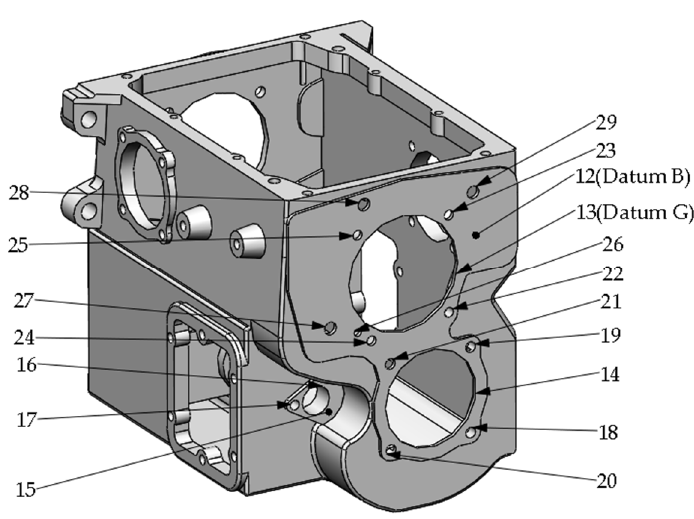
Figure A2. Machining tasks on Front surface.